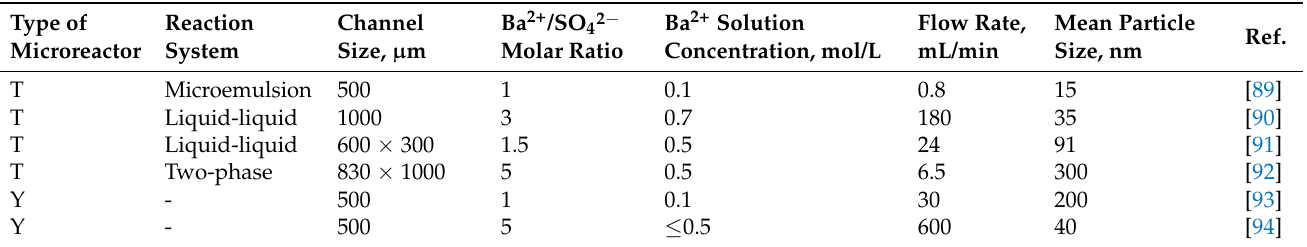
Table 3. Obtaining conditions on the particle size of BaSO 4 NPs produced in T- and Y-microreactors described in the